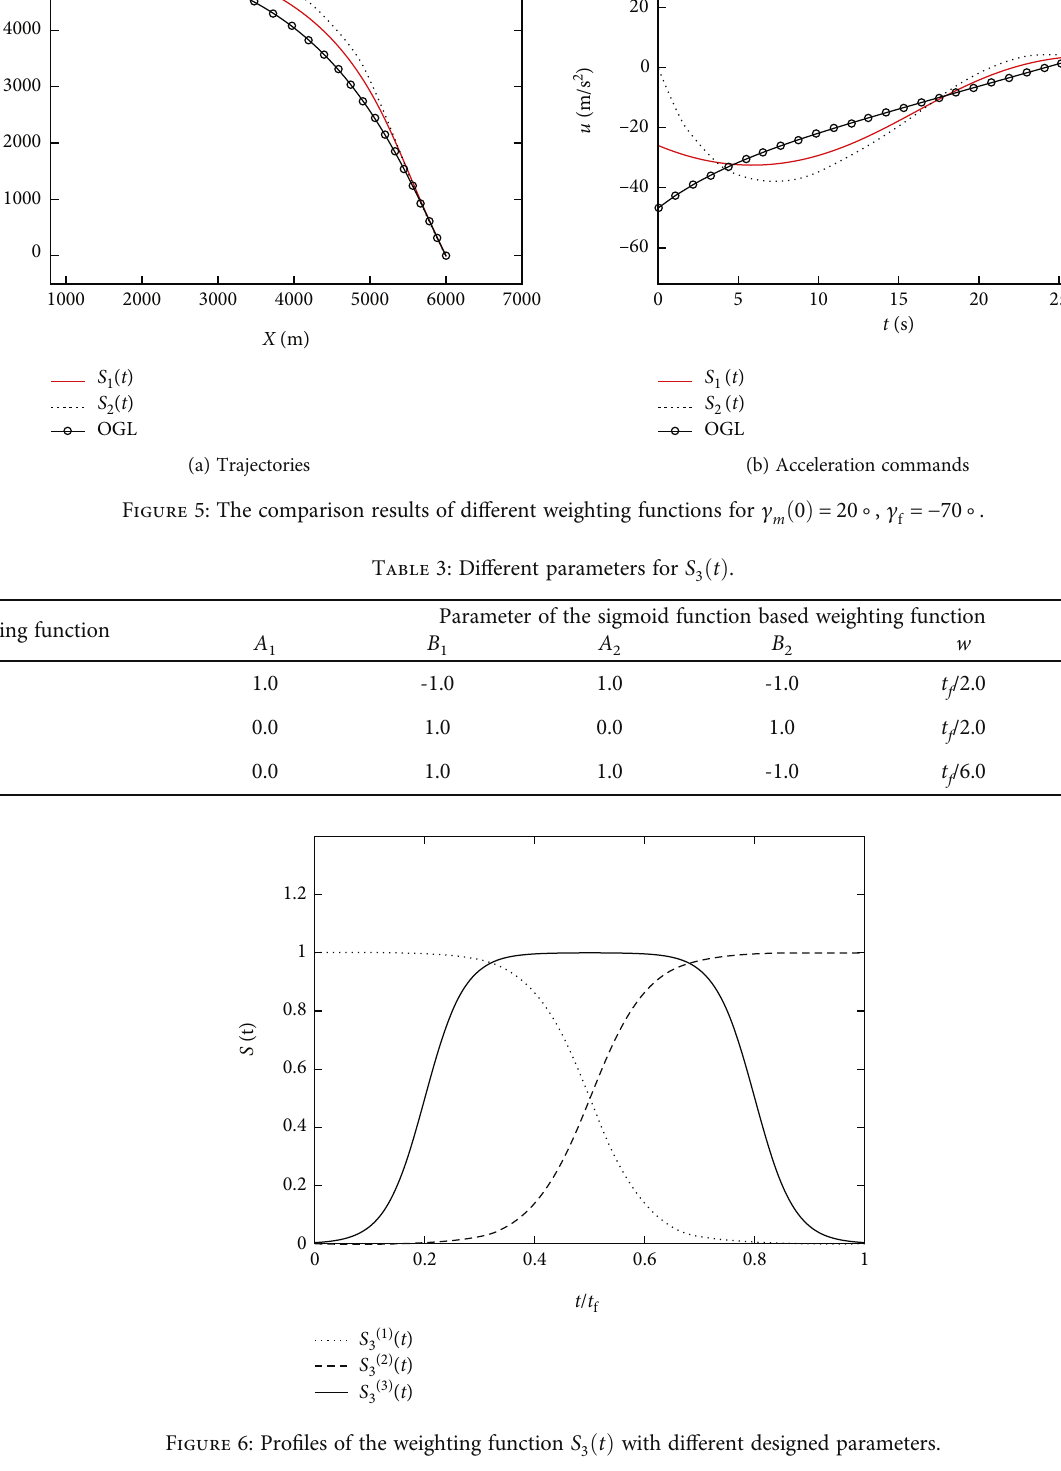
Figure 6: Pro fi les of the weighting function S